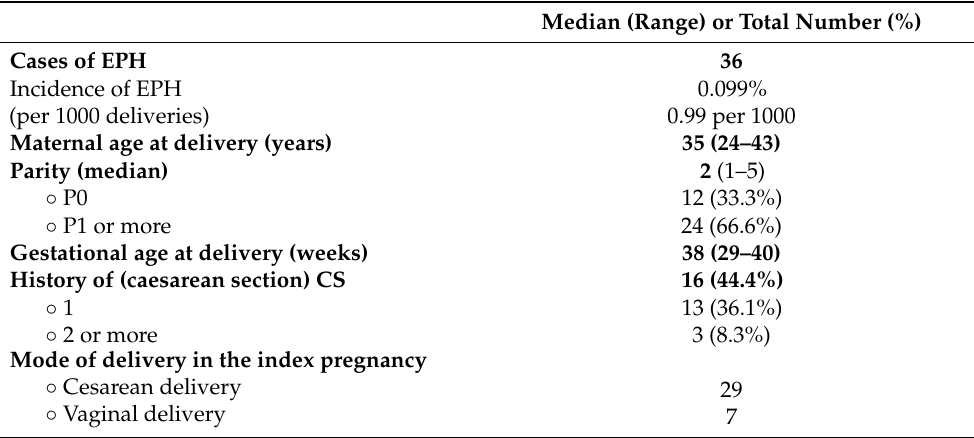
Table 1. Demographic and clinical characteristics of patients that underwent EPH from a total number of 36,099